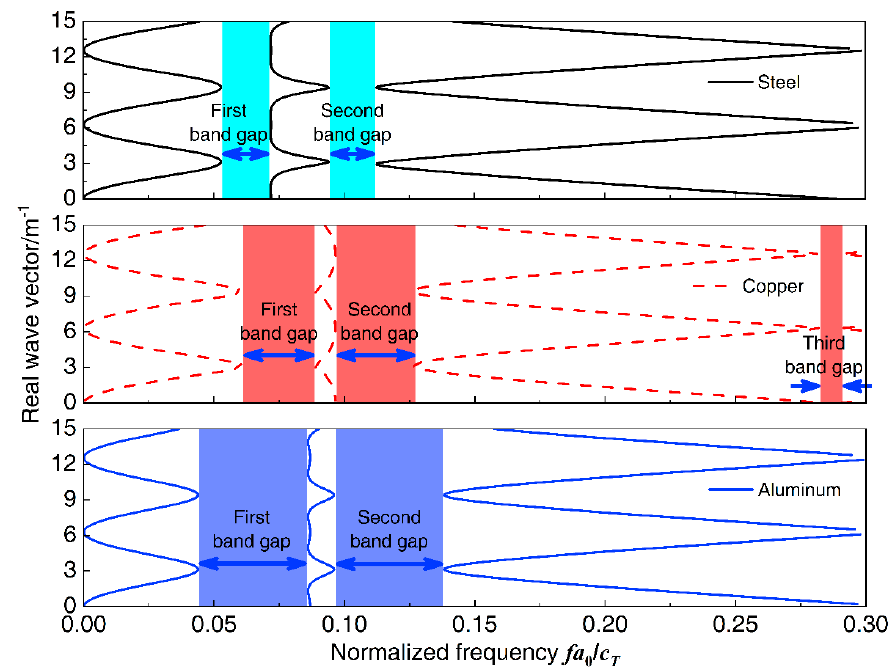
Figure 13. The band gaps of different homogeneous straight damping beam material properties.